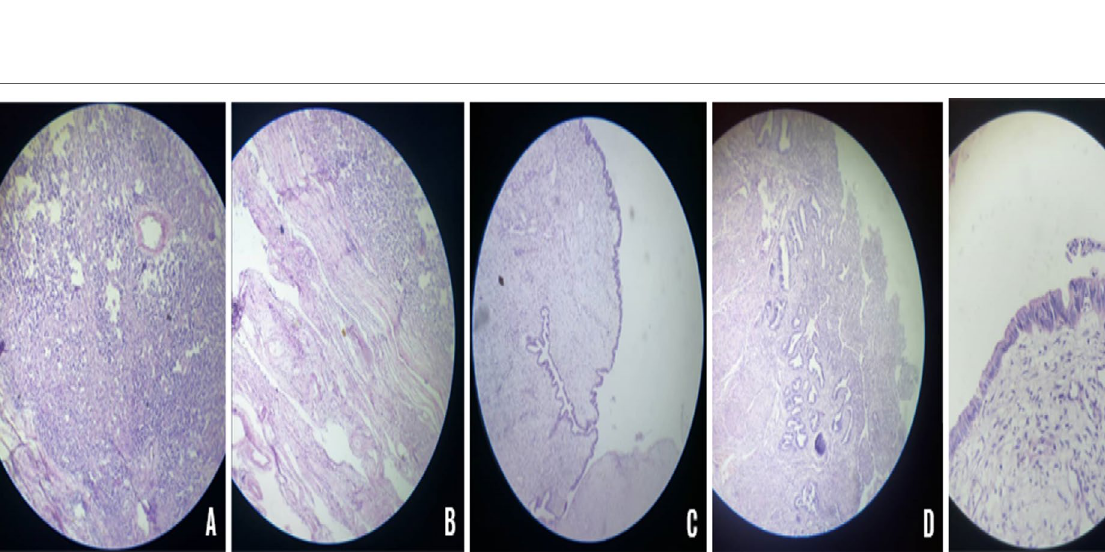
Fig.5 A Sheets and lobular configuration of germ cells with hyperchromatic nuclei and prominent nucleoli surrounded by thin fibrous septa infiltrated by lymphocytes. B Hyalinized seminiferous tubules. C Fallopian tube tissue surrounded by fibro-fatty tissue contains rete testis and efferent ductules. D Atrophic endometrium and myometrium. E Cervix with ulcerated endocervical mucosa, and seminal vesicles